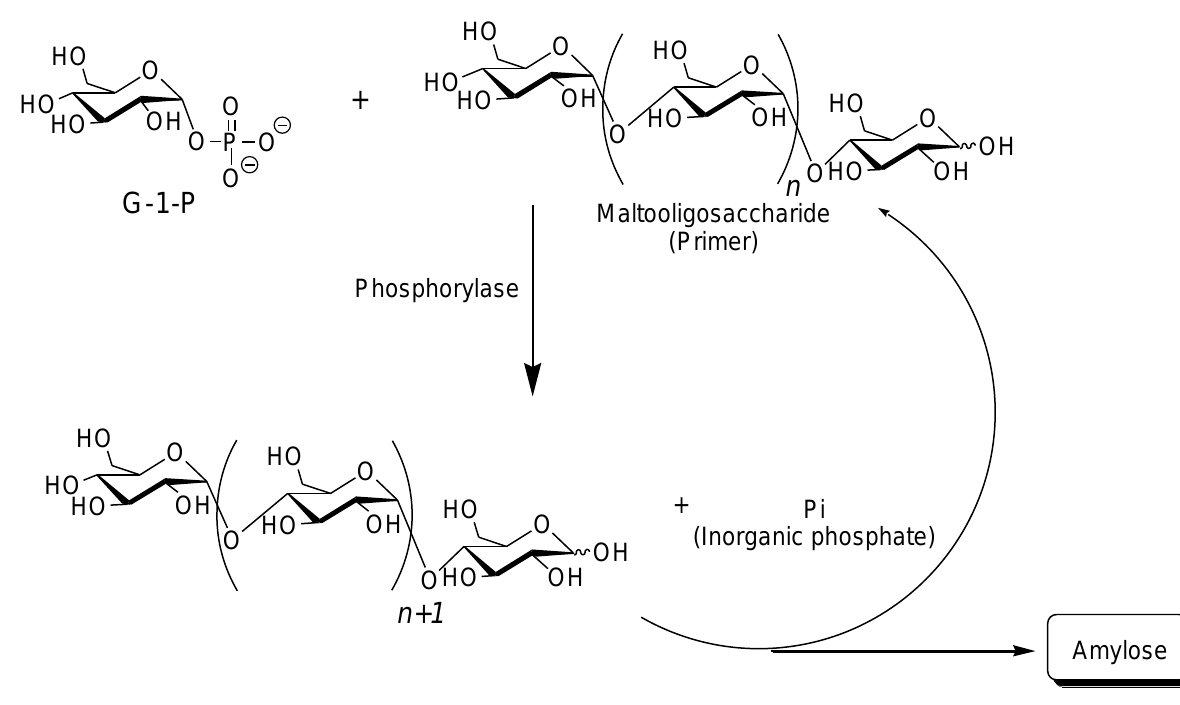
Figure 2. Phosphorylase-catalyzed enzymatic